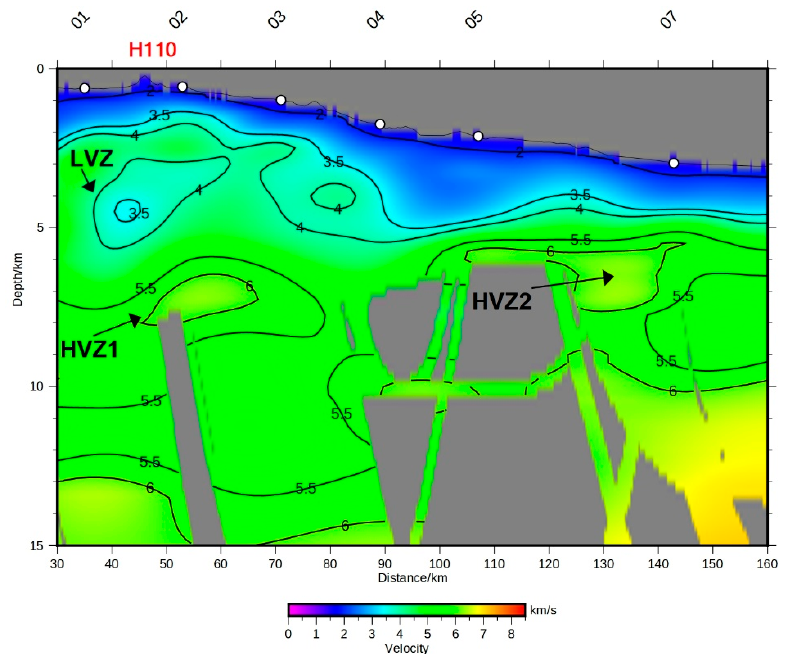
Figure 5. Zoomed velocity profile around the hill H110, showing a large low-velocity (LVZ, 3.3–4 km/s) zone, followed by a high-velocity (HVZ1, 5.5–6.3 km/s) zone at different levels below H110. Another high-velocity one (HVZ2, 5.5–6.3 km/s) appears to its east.